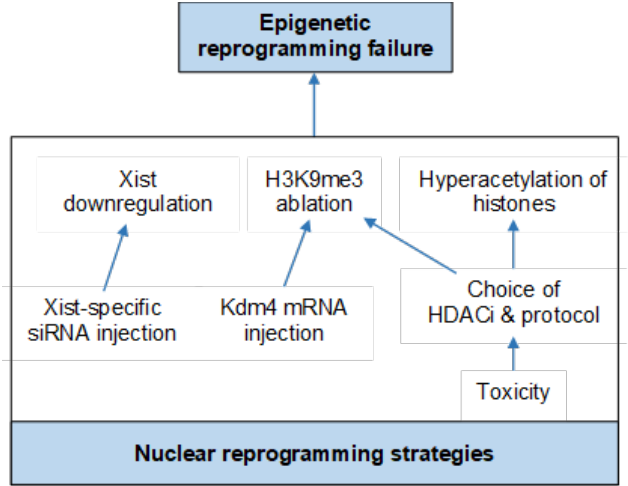
Figure 7. Diagram illustrating the most recent and applicable nuclear reprogramming approaches developed to improve epigenetic reprogramming failure.